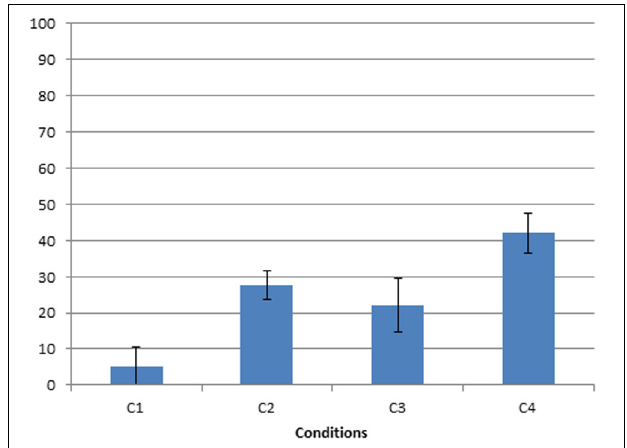
FIGURE 4 | Frequency of pointing first toward the object as a function of condition.